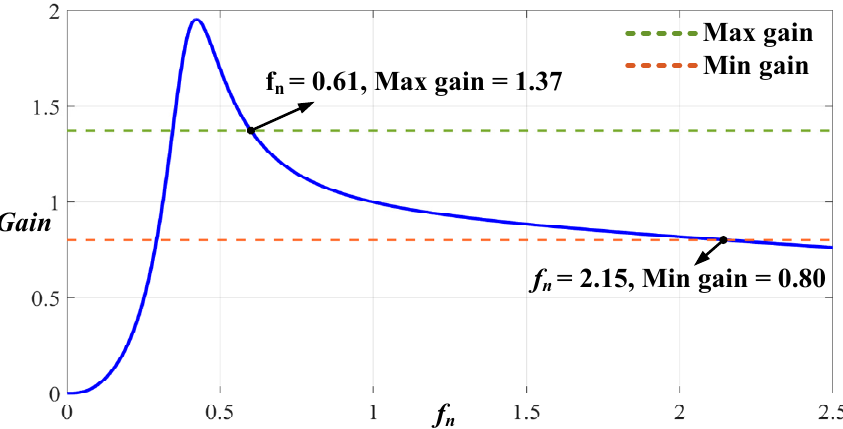
Figure 14. Voltage gain curve of the 2C2L resonant circuit when in V2B mode.